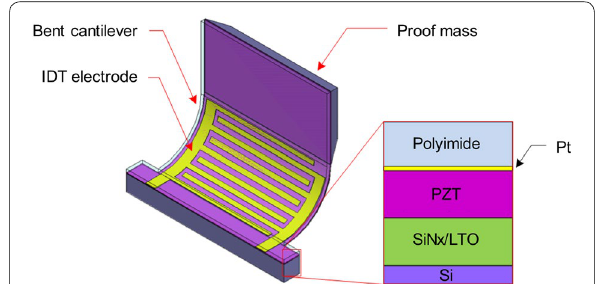
Fig. 1 Schematic drawing of the proposed piezoelectric d 33 -mode MEMS power generator using a flexible and curled PZT cantilever